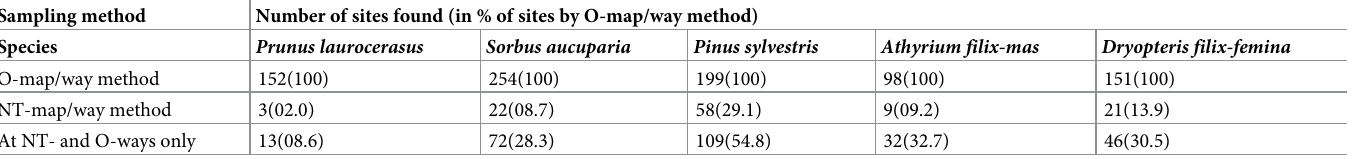
Table 2. Number of plant sites found for 5 plant species by different sampling methods. Sampling